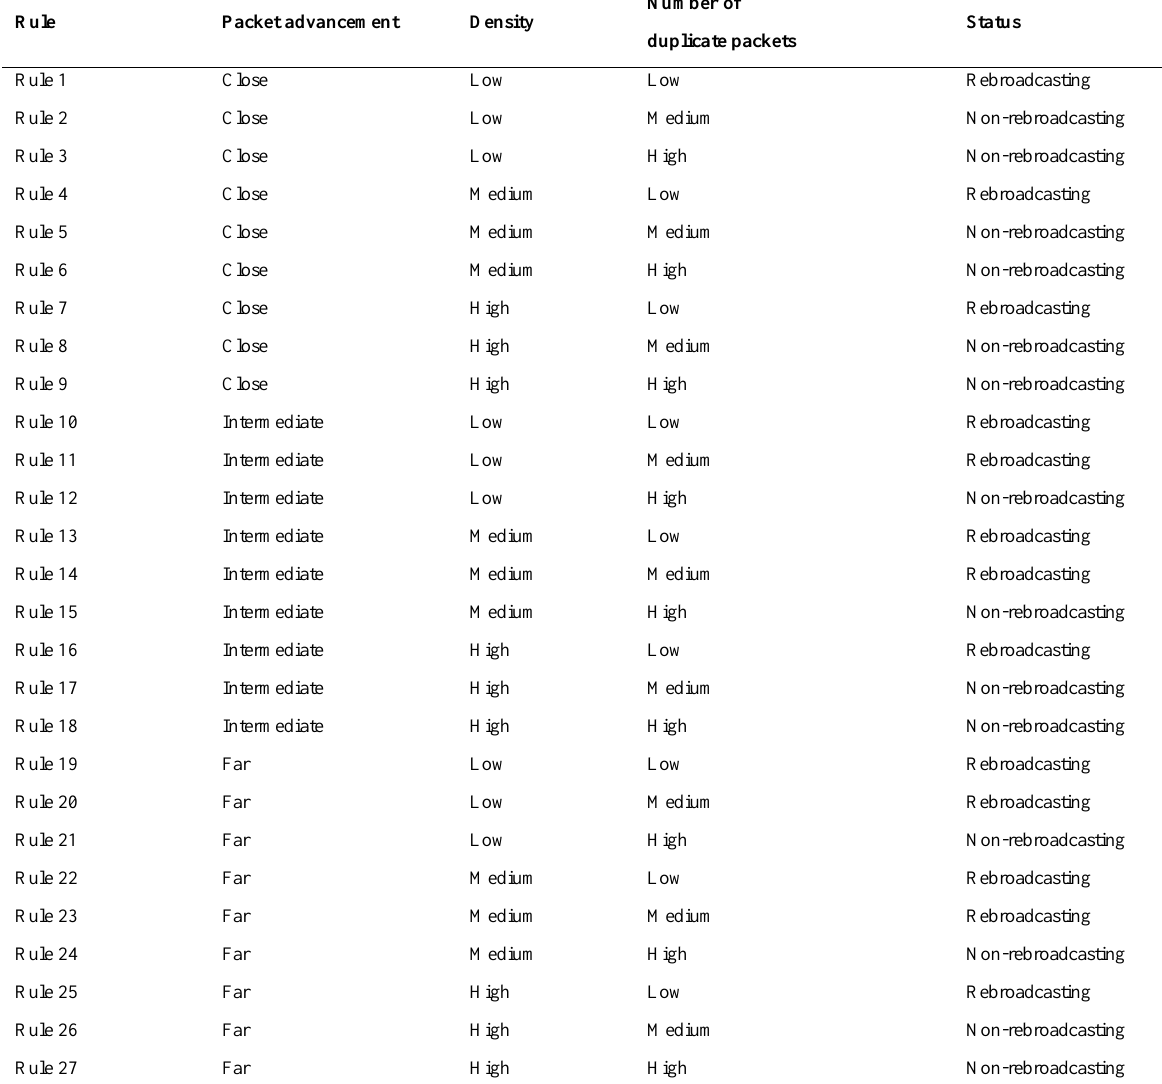
Figure 2. Fuzzy control structure. Table 1. Defined 27 Fuzzy rules based on fuzzy values of input